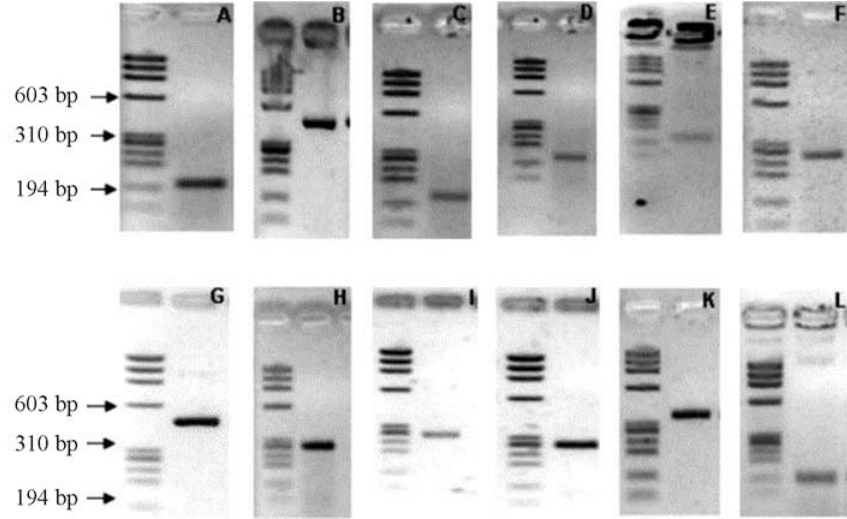
Figure 1 - RT-PCR products. A: IL-2; B: IL-4; C: IL-8; D: IL-12p35; E: IL-13; F: TNF- α ; G: IFN- γ ; H: MCP-1; I: MCP-2; J: MUC-1; K: RPL19; and L: GAPDH. Phi-X174 Hae III was used as a molecular